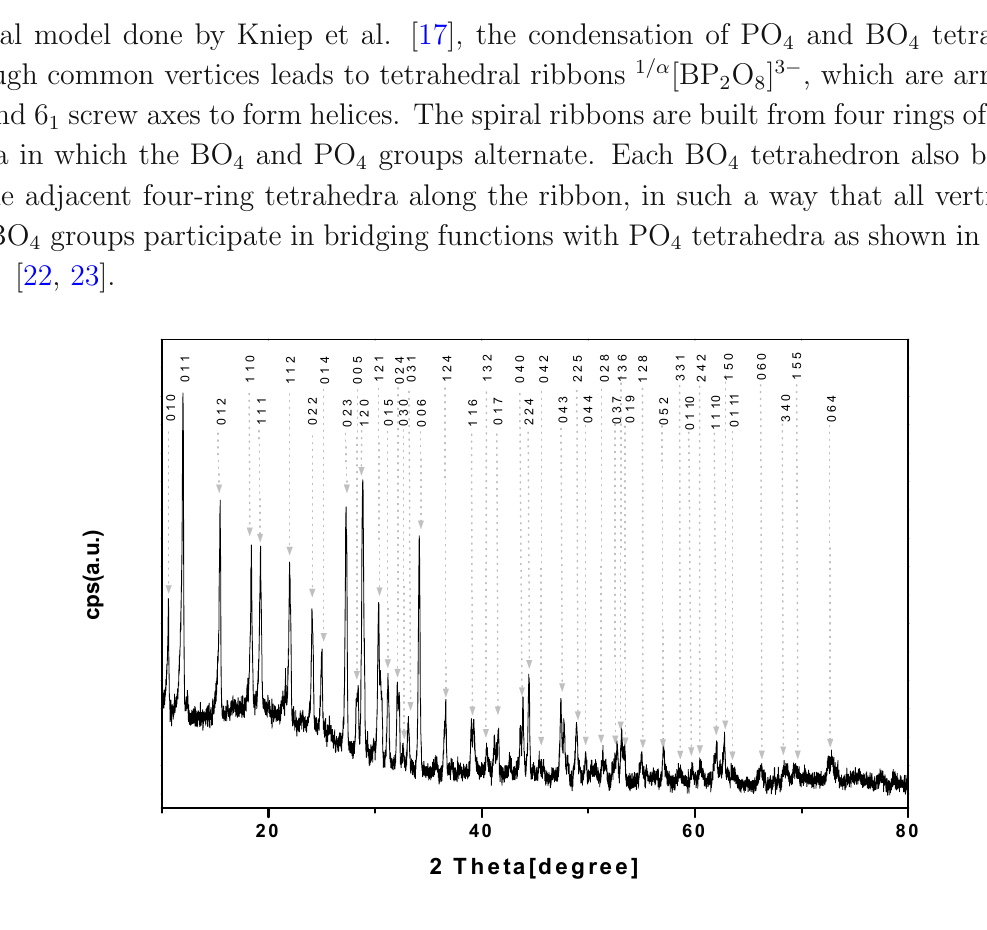
Fig. 1 X-ray powder diffraction pattern of (NH 4 ) 0 . 5 Mn 1 . 25 (H 2 O) 2 [BP 2 O 8 ] · 0.5H 2 O washed with hot H 2